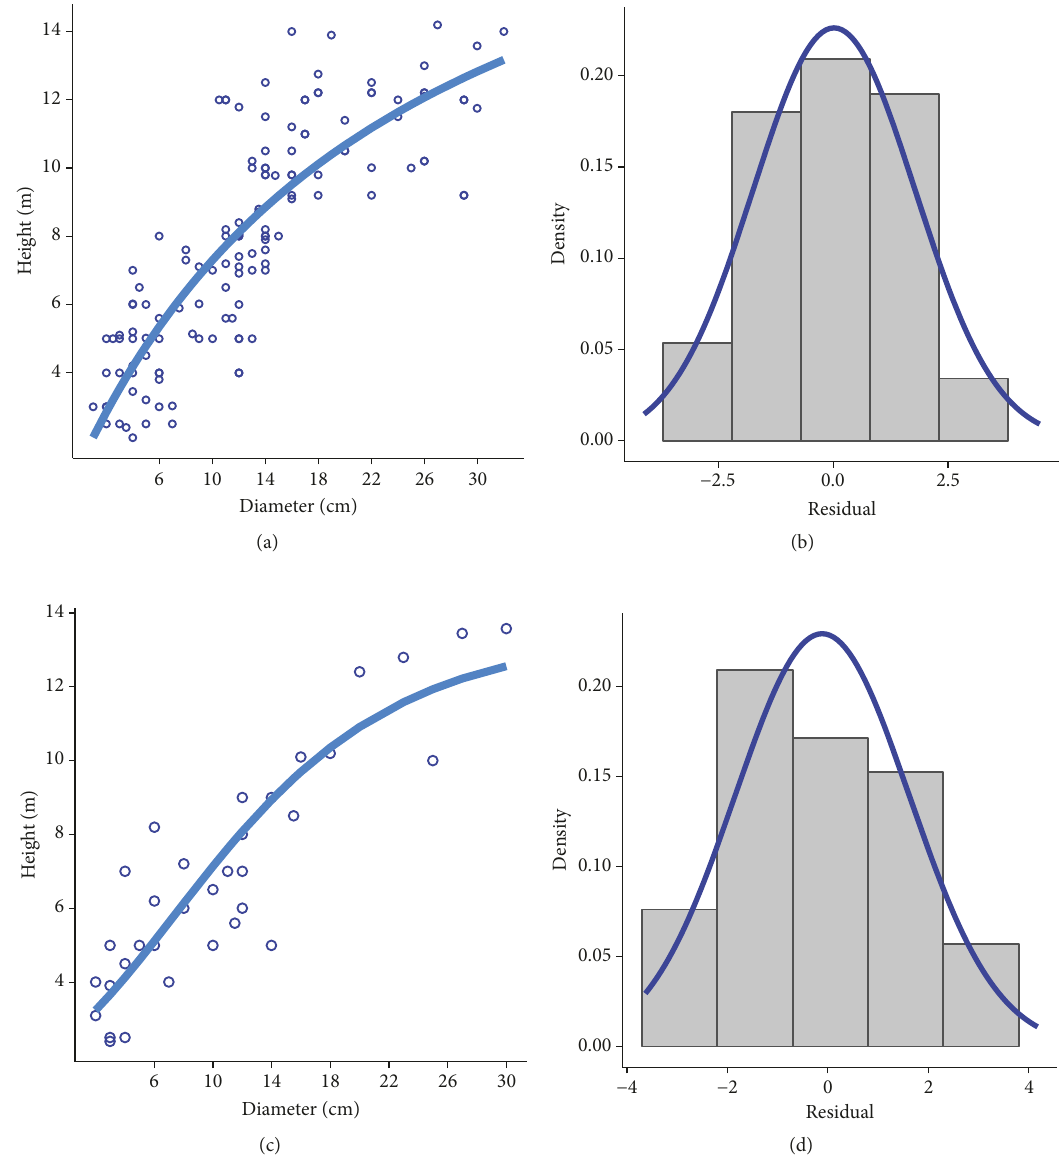
Figure 2: Scatterplot of total height(H) against D superimposed with M14 for fitting data (a) and validation data (c); a histogram of residuals of M14 for fitting data (b) and validation dataset